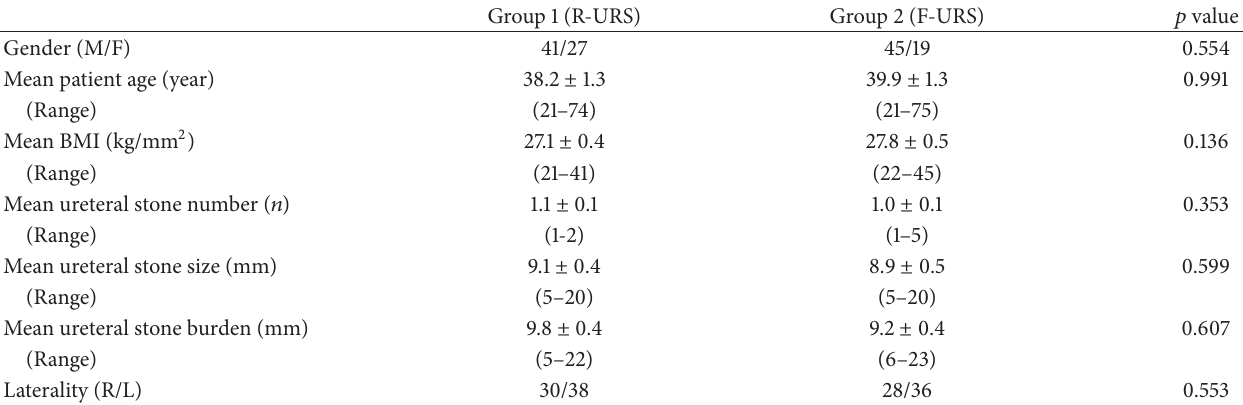
Table 1: Patients’ demographics data and stone characteristics.